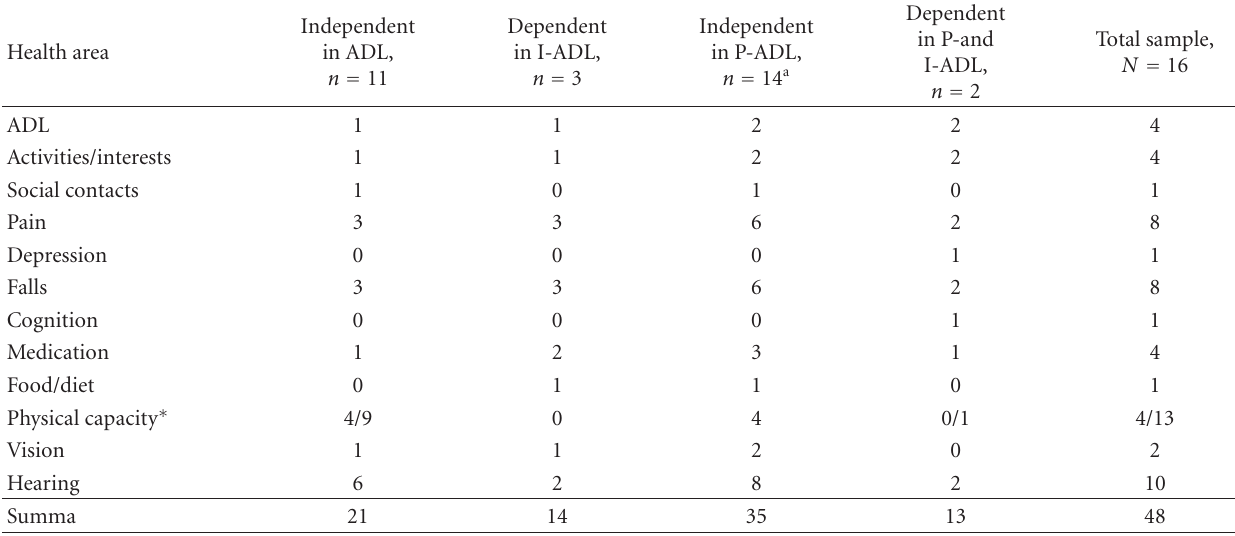
Table 3: Number of identified health risks within each health area in the PHV protocol in the pilot study, in total and according to ADL-level group, N = 16.